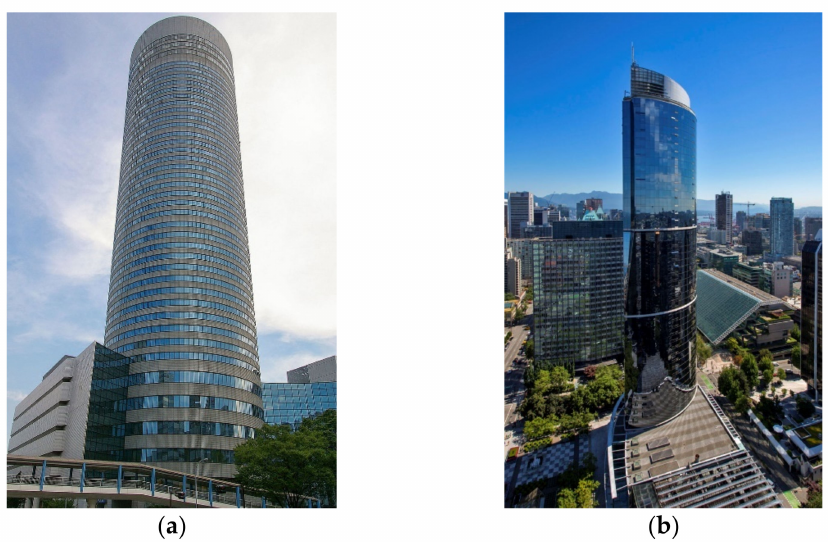
Figure 7. ( a ) Shin Yokohama Prince Hotel